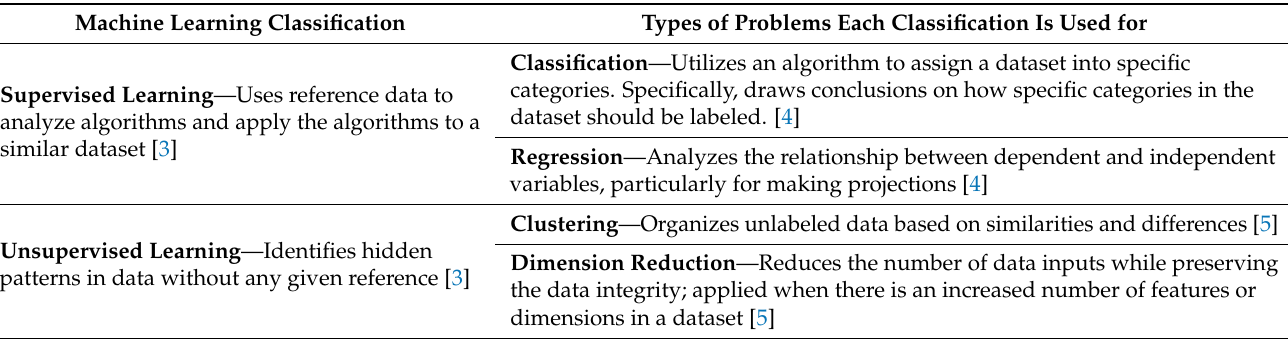
Table 1. Methodology of supervised and unsupervised learning within machine